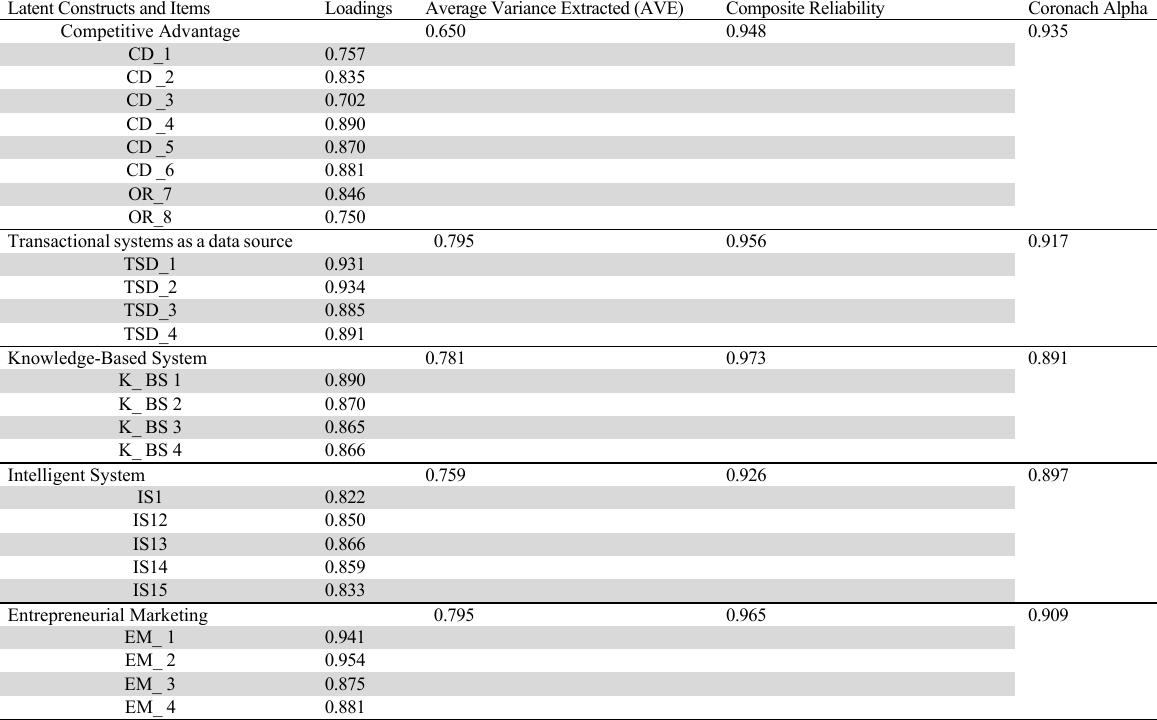
Convergent Validity and Reliability